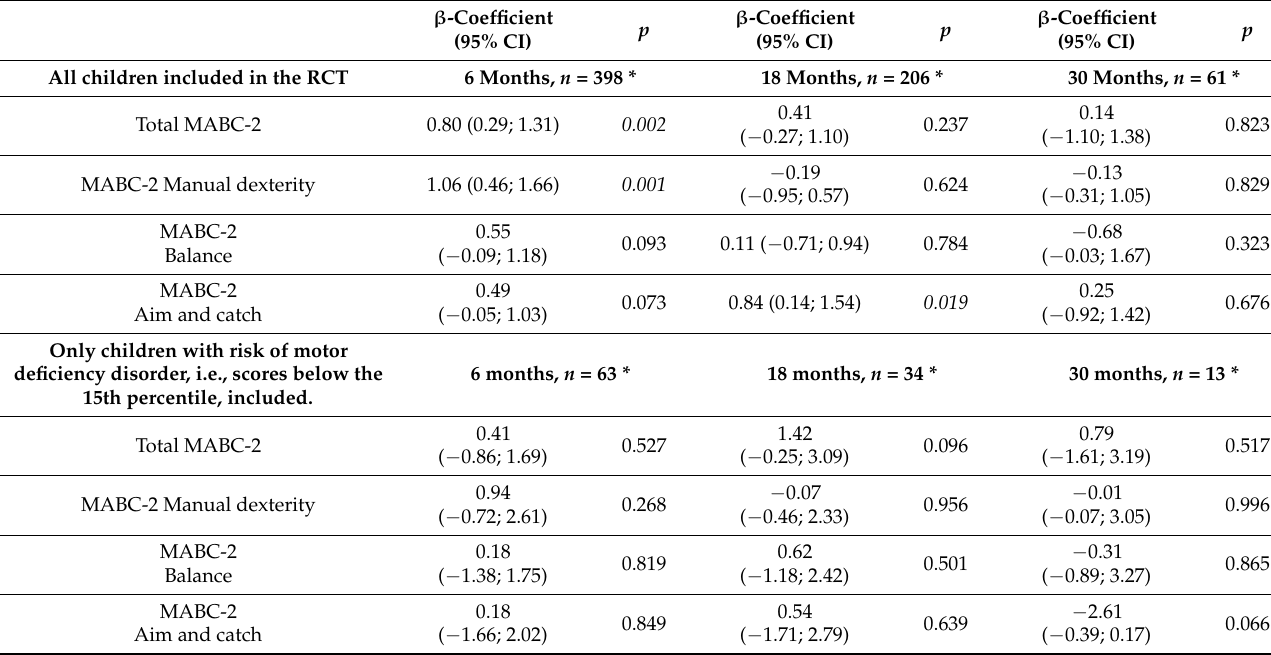
Figure 2. Predicted outcomes of MABC ‐ 2 with 95% confidence intervals at each time point for the two groups. ( a ) depict the total score, ( b ) the manual dexterity domain, ( c ) the balance domain, and ( d ) the domain for aiming and catching. Predictions are based on a model with the same random effects structure as the model used in the main analysis, but use the baseline values as outcome and not as covariate. Table 6. Effect of intervention ( β -coefficient with 95% confidence interval) on motor skills in preschool children at the three follow ‐ up times. Motor skills measured using MABC ‐ 2.